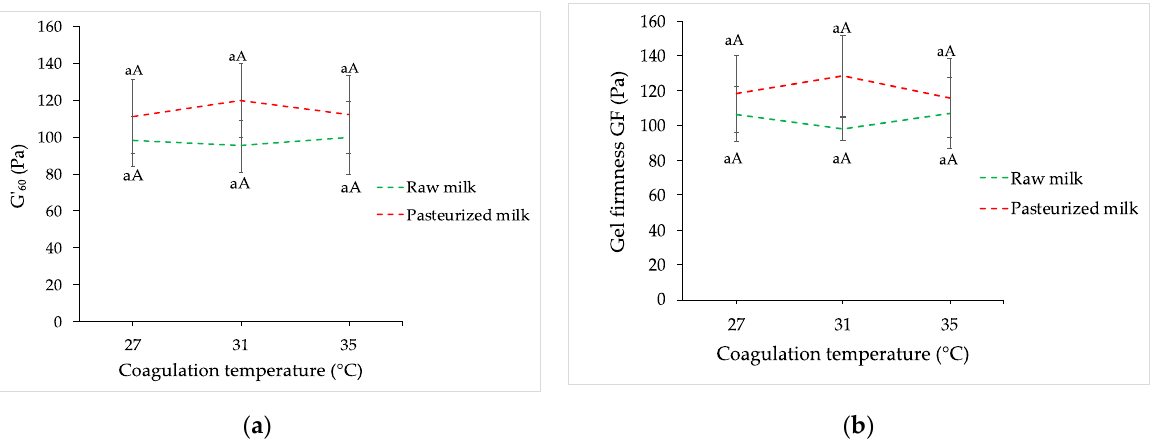
Figure 8. Influence of coagulation temperature and heat treatment of milk on: ( a ) gel firmness G’ 60 (Pa) and ( b ) GF (Pa). Values with lowercase letters indicate no differences between levels of milk pH, and uppercase letters indicate no differences between milk heat treatments (raw/pasteurized). Comparison of means was performed by Tukey HSD test ( p <